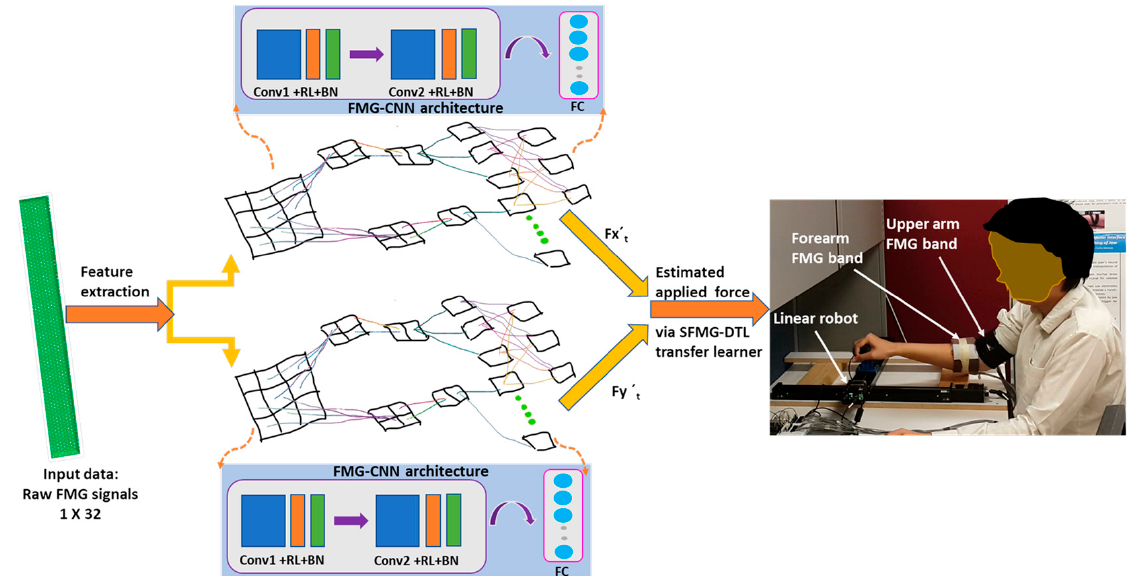
Figure 1. The proposed SFMG-DTL transfer learning model for estimating applied force during pHRI on a planar workspace with a linear robot.